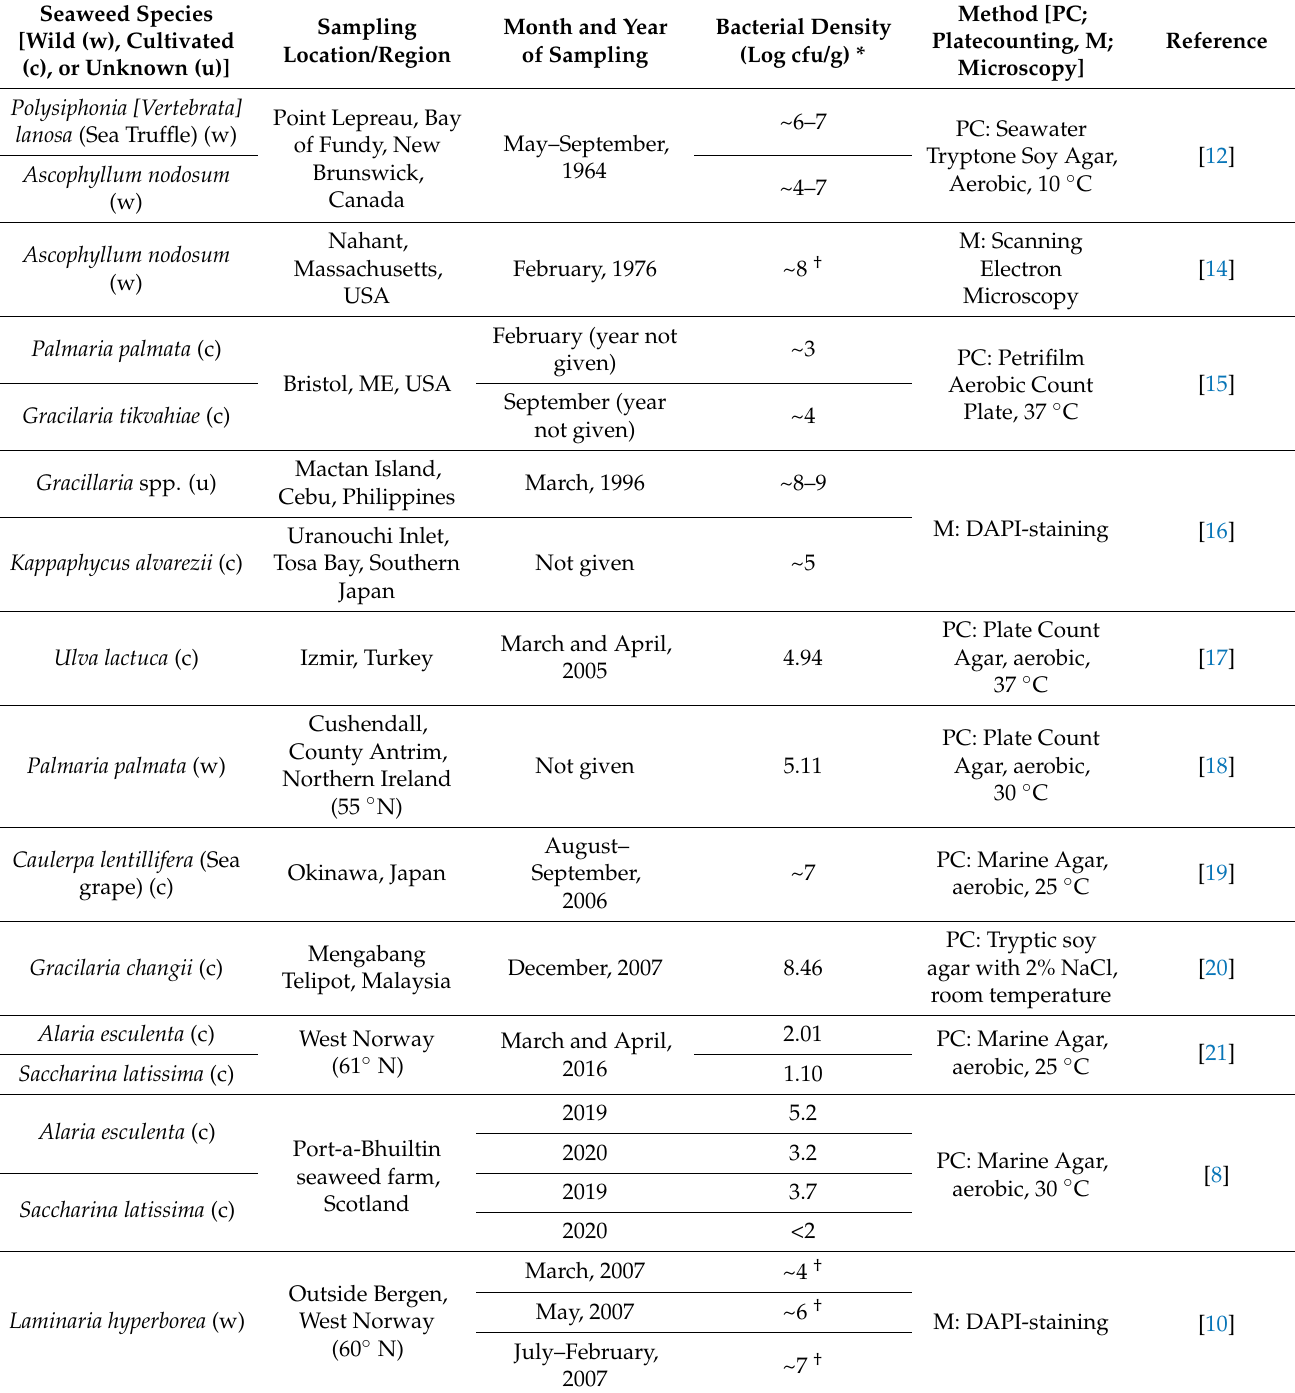
Table 1. Reported viable bacteria counts for selected seaweed species of relevance for human